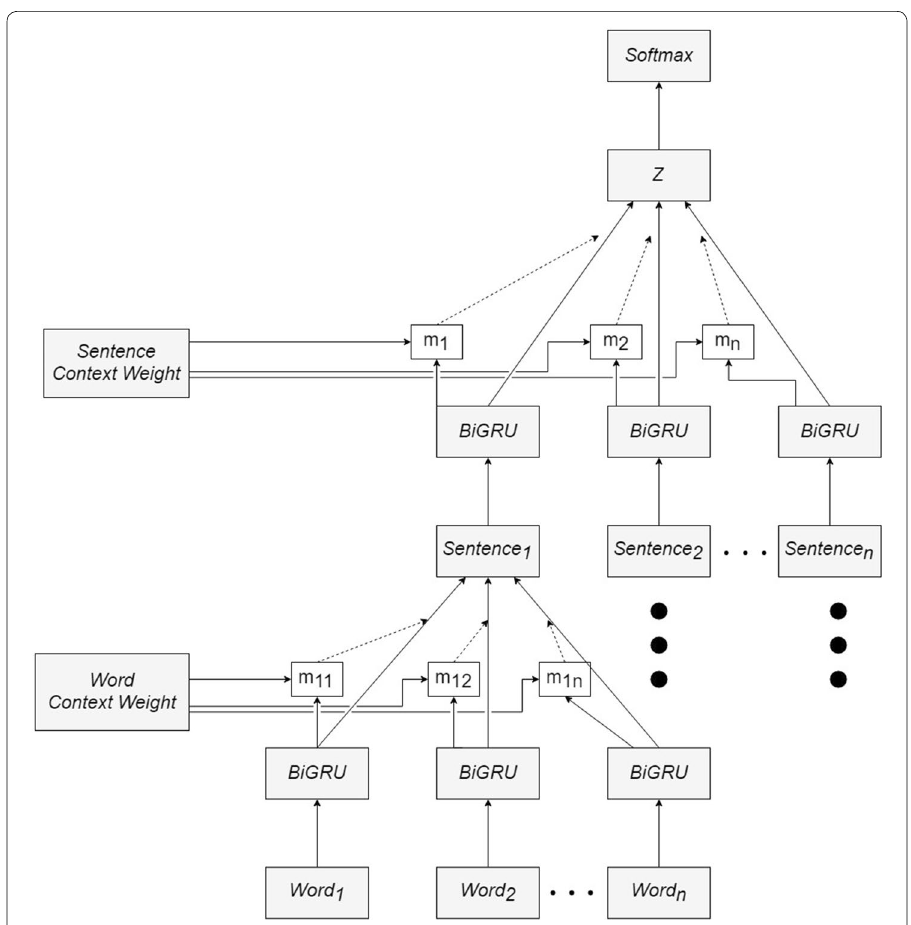
Fig. 5 Hierarchical Attention Network (HAN) for argument analysis